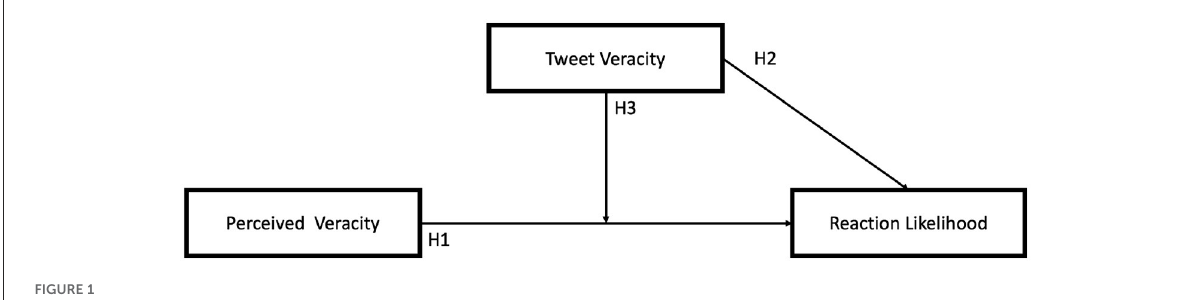
FIGURE1 Hypothesis